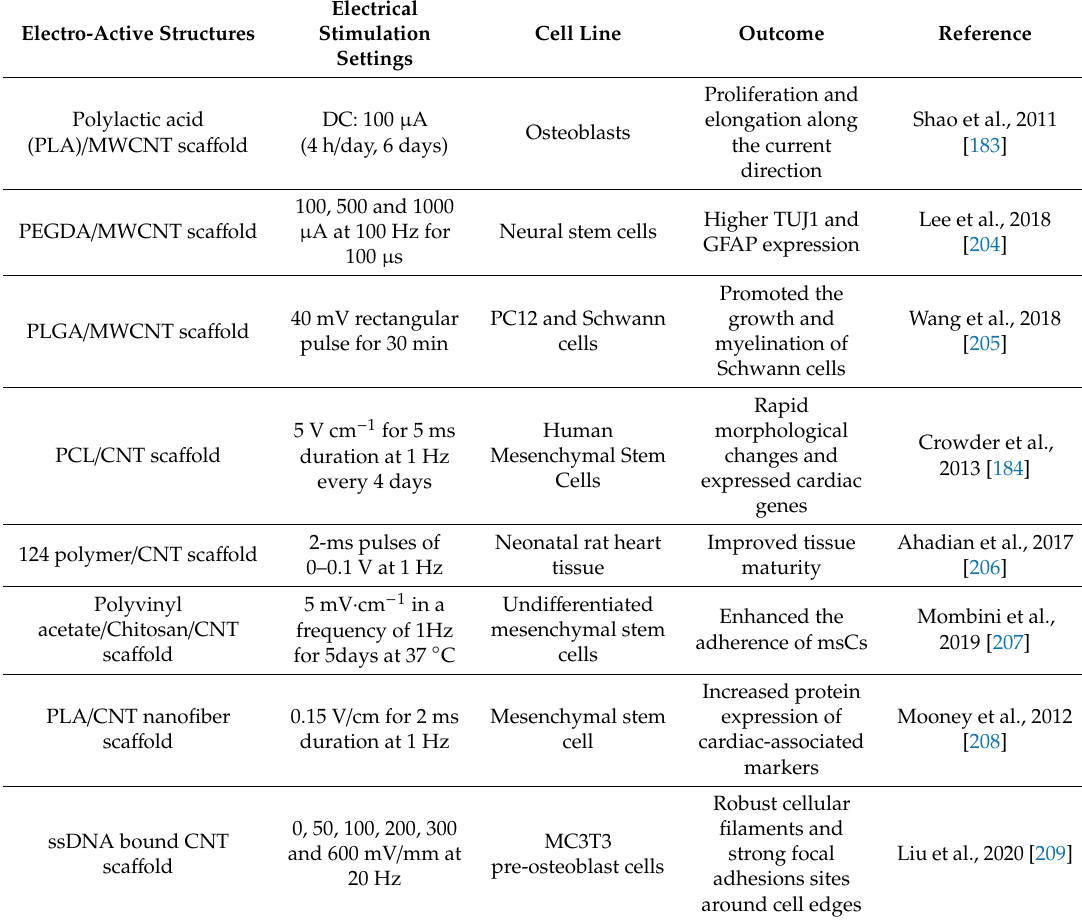
Table 3. Studies using CNT electro-active